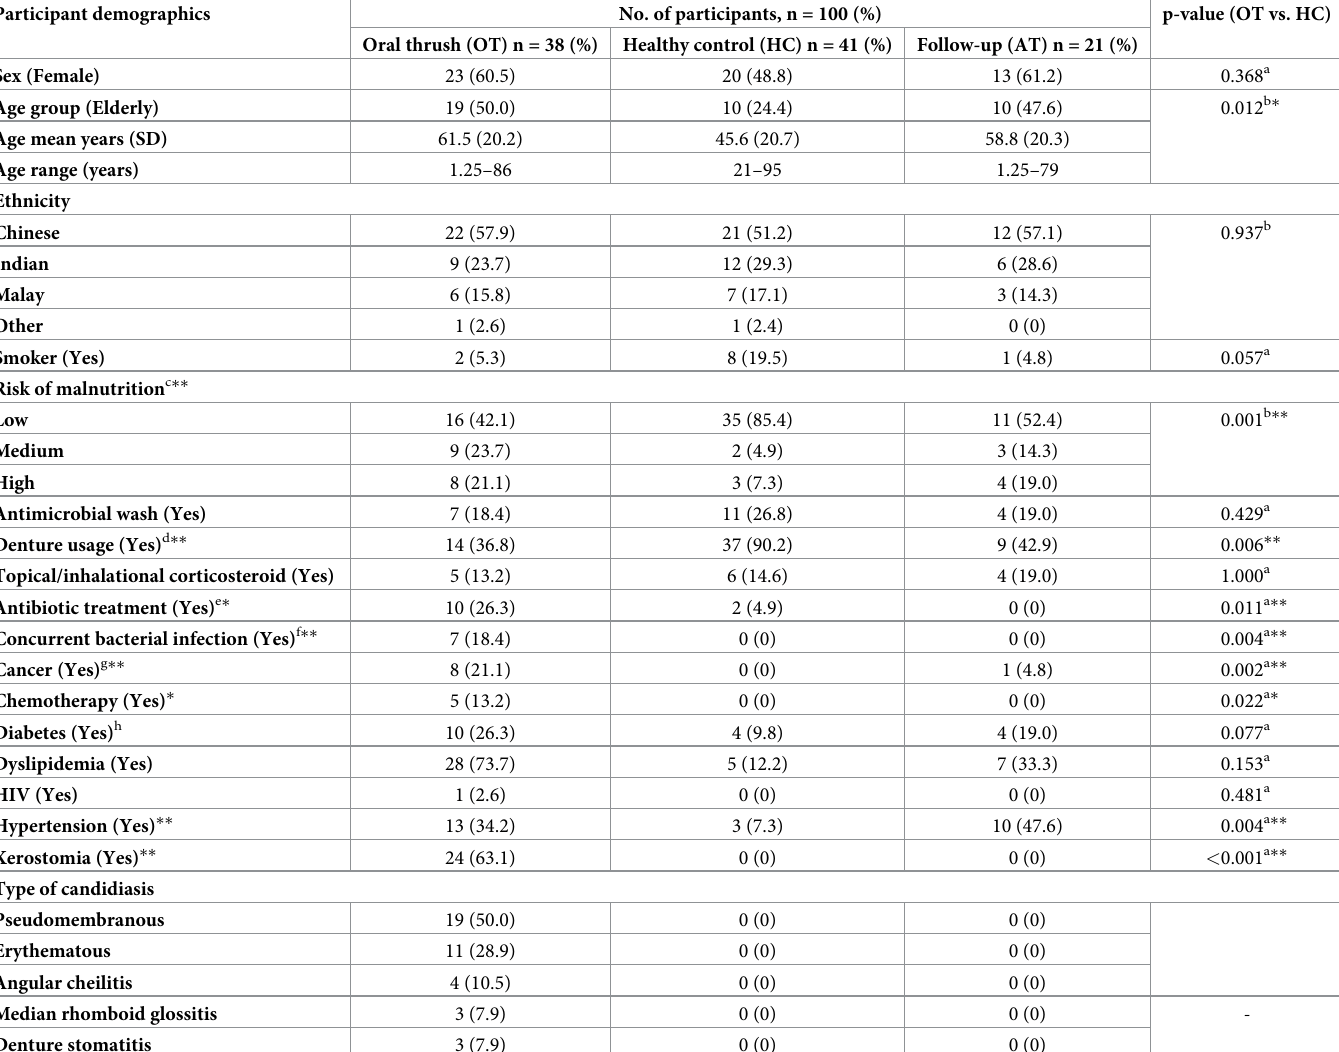
Table 1. Demographic information of study